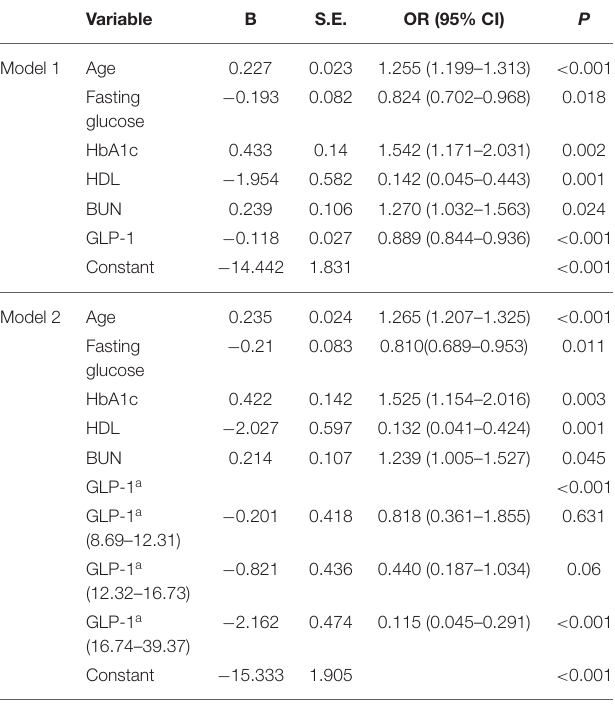
TABLE 3 | Multivariable regression analysis for the risk of CAVD. Variable